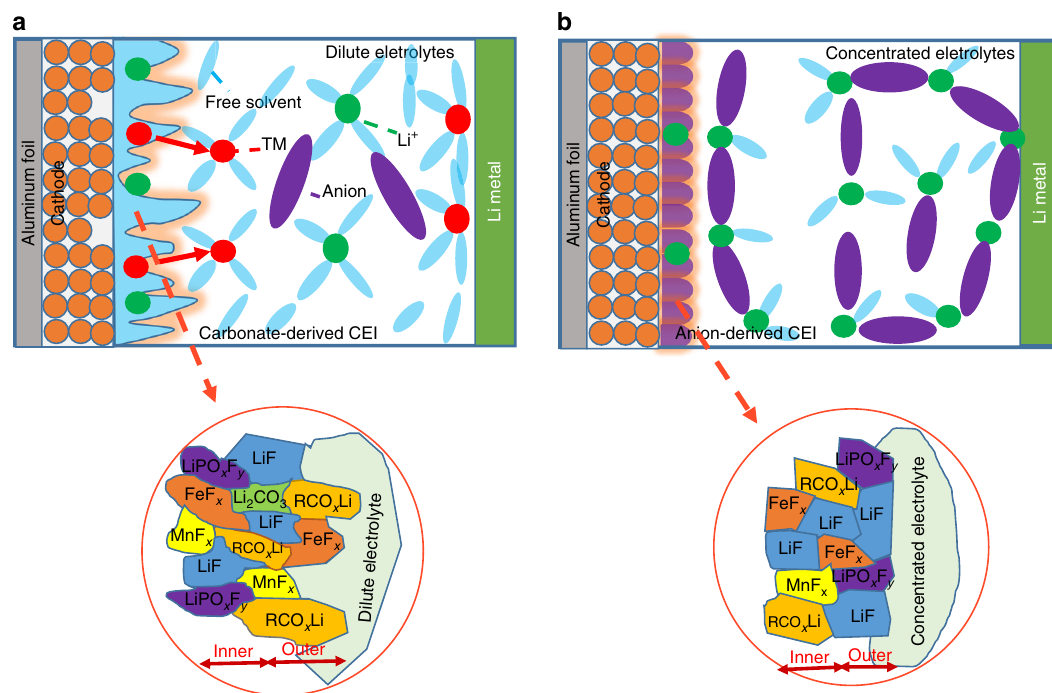
Fig. 7 Schematic illustrations of passivation fi lms in 1 and 3 M electrolytes. a Schematic of carbonate-derived (organic-rich) CEI formed on the surface in 1 M electrolyte; b schematic of inorganic-rich CEI formed on the surface in 3 M